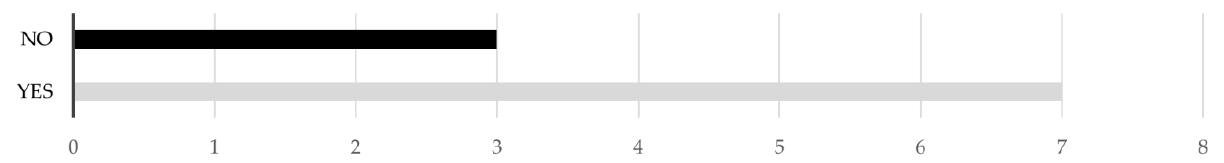
Figure 13. Responses to the question: “Do you think that more specialists in the team of the lead-appointed party should be dedicated to BIM management and BIM coordination activities in the future?” .